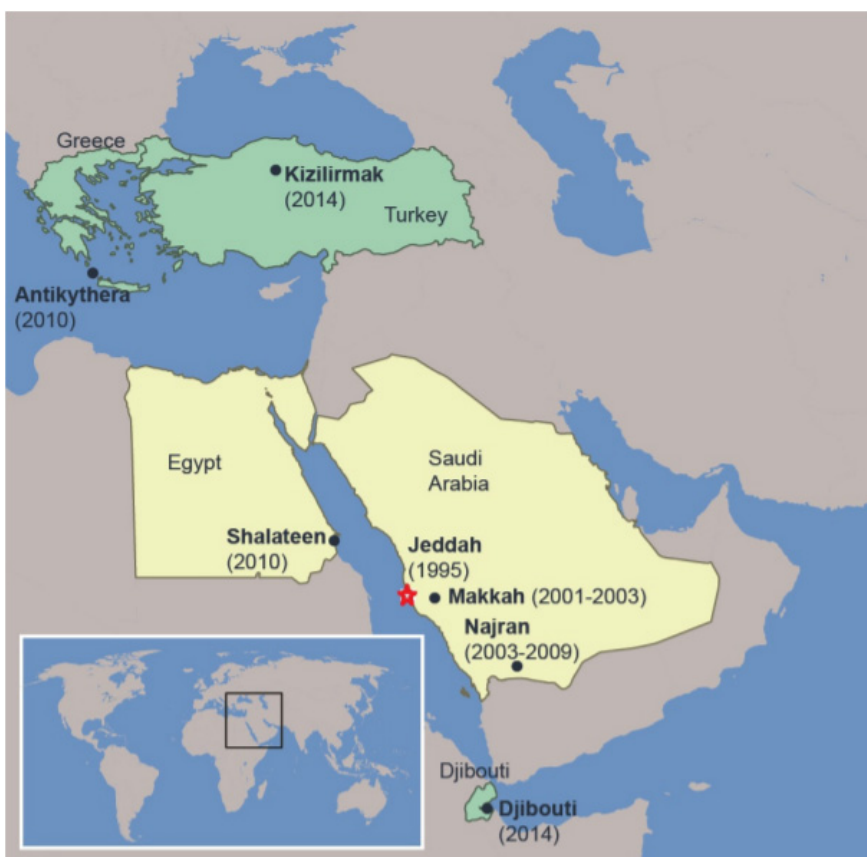
Figure 3. AHFV distribution in middle eastern countries. Yellow areas indicate human disease caused by AHFV in Egypt and Saudi Arabia. Greece, Turkey, and Djibouti (depicted in green) represent the places were viral RNA was found in ticks. Place, state, and year in which the first case was reported are provided. Star represents the place of the first human case.